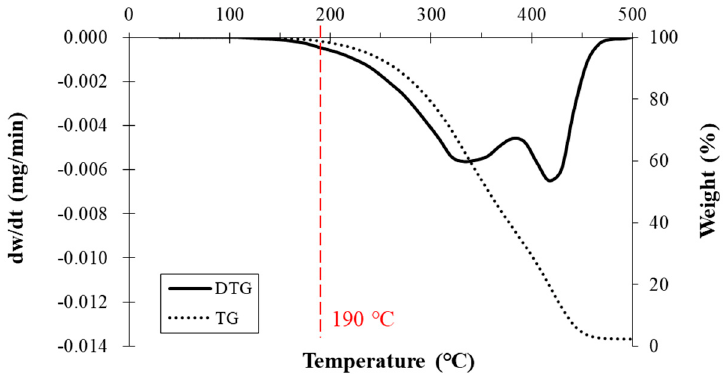
Figure 9. Thermogravimetric analysis (TGA) and derivative thermogravimetric (DTG) profiles of the spent lubricant.